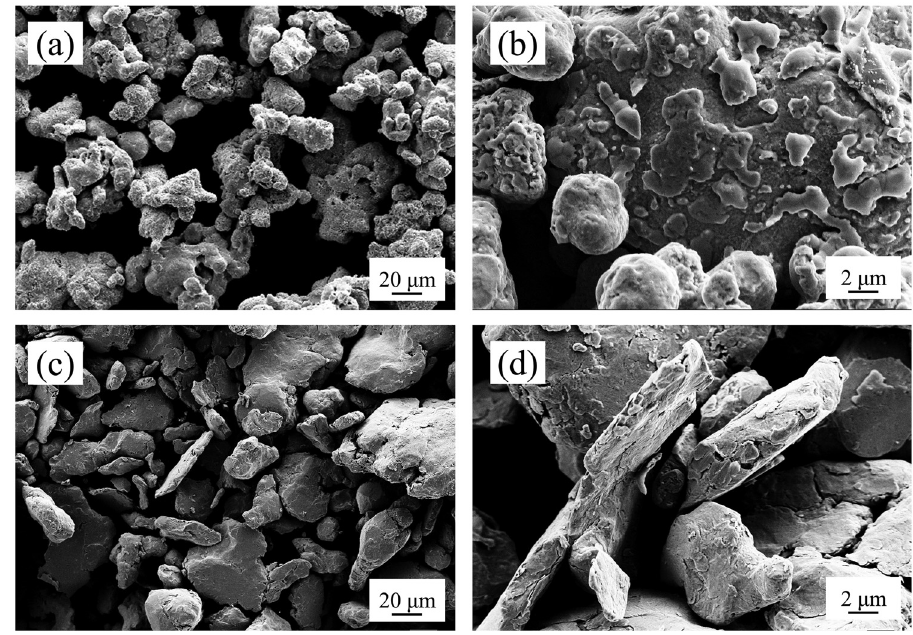
Figure 2: Low - magni fi cation ( a and c ) and high - magni fi cation ( b and d ) SEM images of raw powder and milled